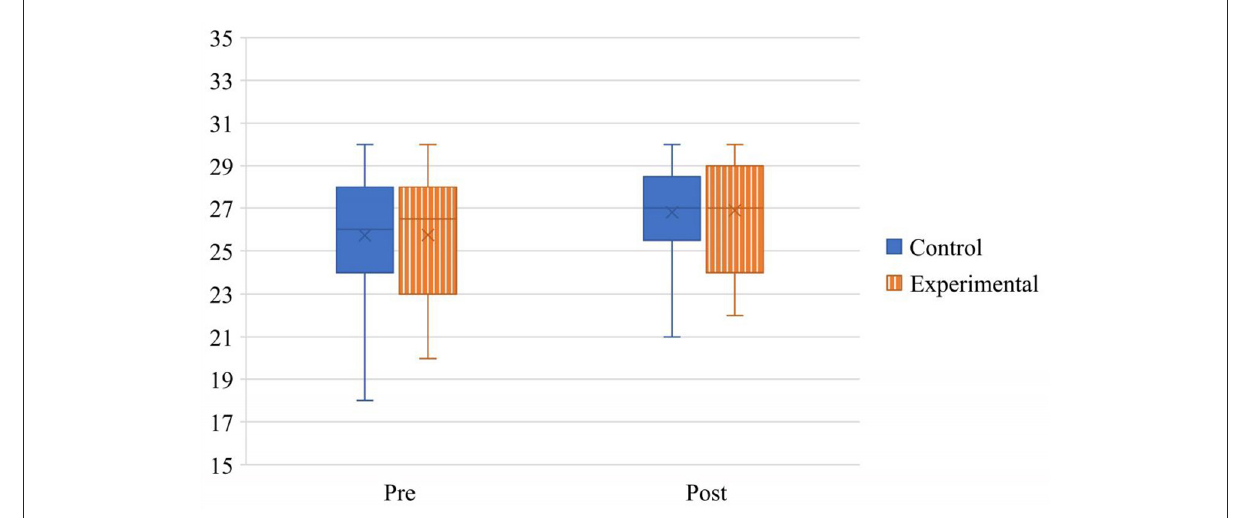
FIGURE3 Main effect of time on teachers’ beliefs about the universality of abilities.